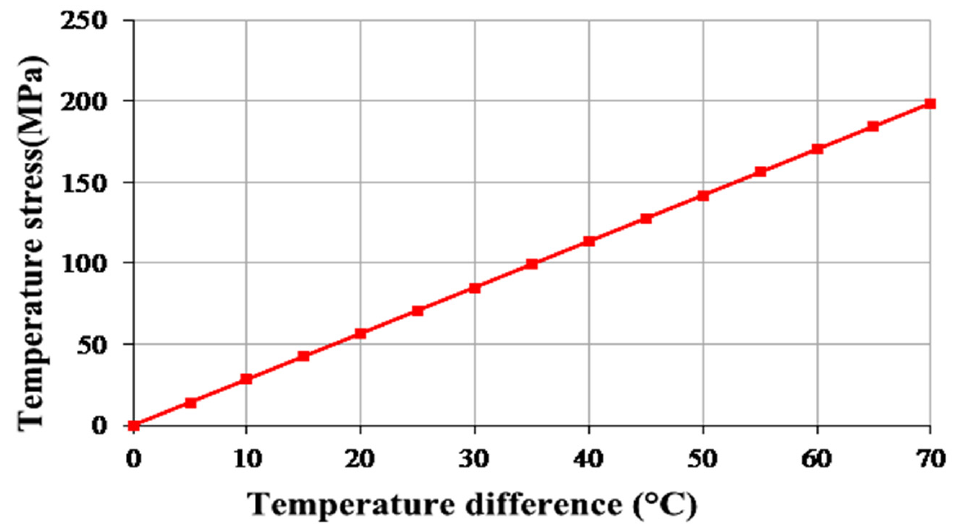
Figure 6. Temperature stress of casing under different temperature difference. For well A, the casing extrusion strength of 139.7 mm casing (P110 steel grade) under different temperature stresses can be calculated by Formula (11), as shown in Figure 7. With the increase of the temperature stress on the casing, the outer extrusion strength of the three kinds of casing with thick wall decreases gradually. When the temperature stress reaches 200 MPa, the outer extrusion strength of the casing decreases to 84%.